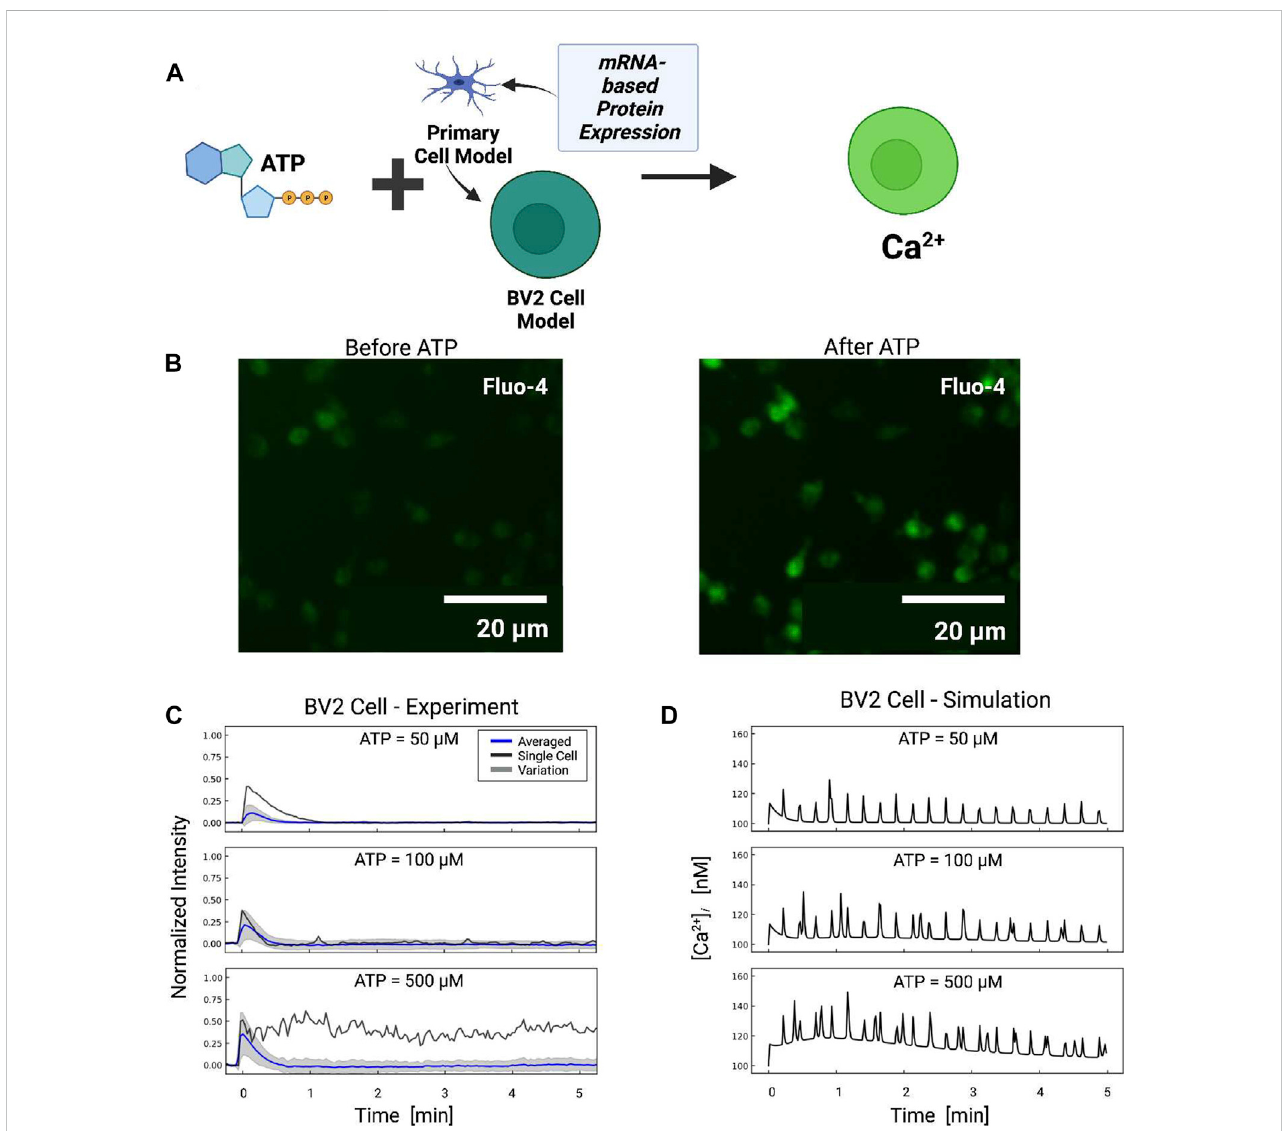
FIGURE 7 (A) Schematic of ATP-induced Ca 2+ transients in BV2 cell simulations assuming P2 expression levels inferred from BV2 cell mRNA (He et al., 2018). (B) Ca 2+ transients measured in BV2 microglia before and after ATP treatment. (C) Experimentally measured (blue) and predicted (red) Ca 2+ transients from BV2 microglia. The shaded area represents the variation in signals measured in all cells. Oscillatory calcium signals were observed and a representative example of which is reported for each ATP dose (black). Transients recorded in each cell are reported in Fig. S7. (D) Predicted transients in primary microglia for